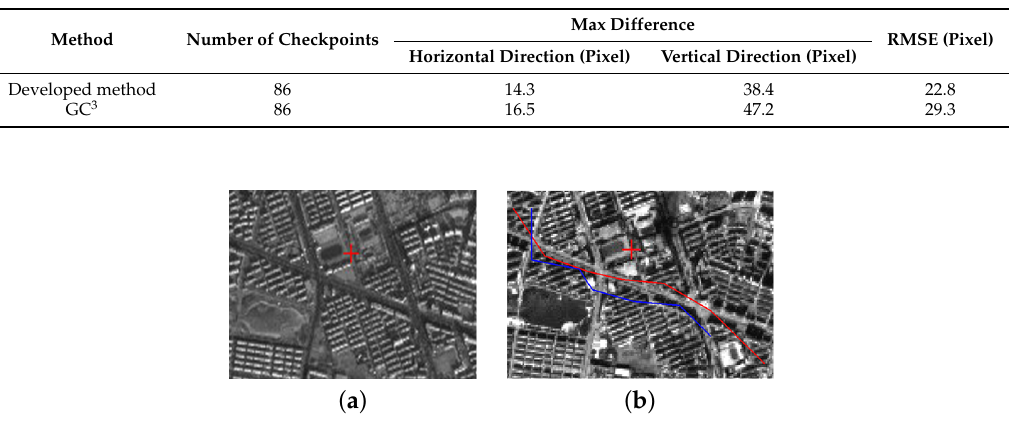
Table 1. Comparison of the prediction accuracy of epipolar lines. GC 3 , Geometrically-Constrained Cross-Correlation.